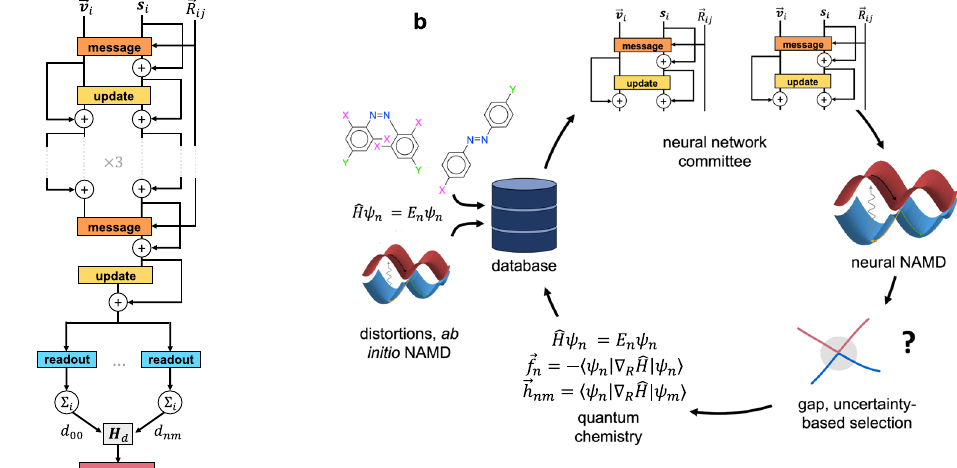
Fig. 2 Neural network architecture and active learning loop. a Schematic of the DANN architecture, which is based on the PaiNN model. Scalar atomic ! features s i and vectorial atomic features v i are updated through messages from neighboring atoms. The s i are then mapped to atomic energies, which are summed to produce the diabatic Hamiltonian H d . The diabatic matrix is diagonalized to produce adiabatic quantities. b Schematic of the active learning loop. Geometries and QC data are fi rst generated through ab initio NAMD, normal mode sampling, and inversion/rotation about the central N = N double bond. Two neural networks are then trained on the data and used to perform DANN-NAMD. Newly generated geometries with high committee variance and/or low predicted gaps receive QC calculations. The new calculations are added to the training data, the networks are retrained, and the cycle is repeated until